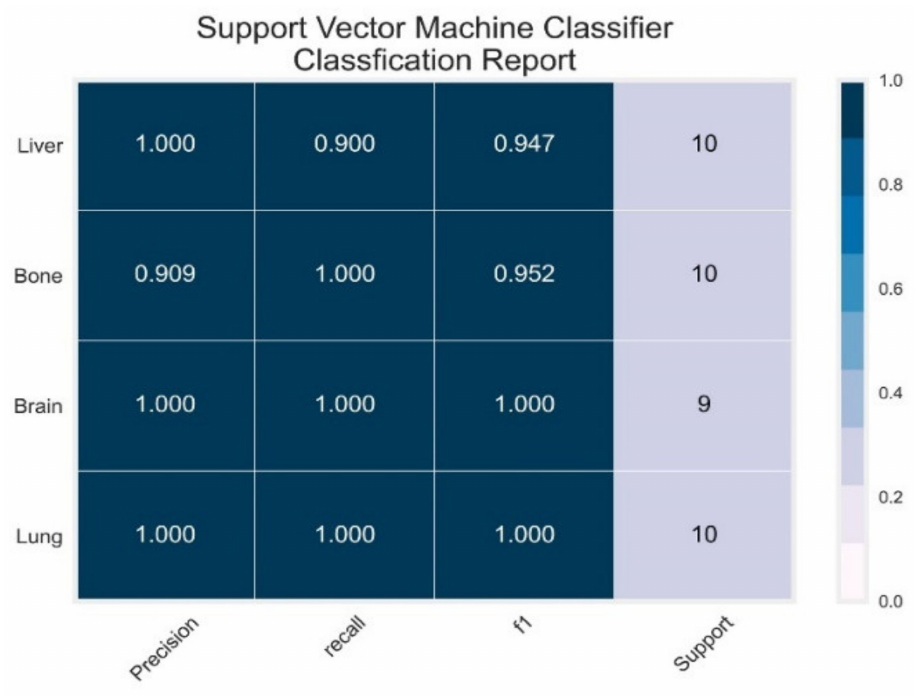
Figure 26. Classification Report (Support Vector Machines). The precision-recall curve for the SVM classifier applying the one-vs-rest method is shown in Figure